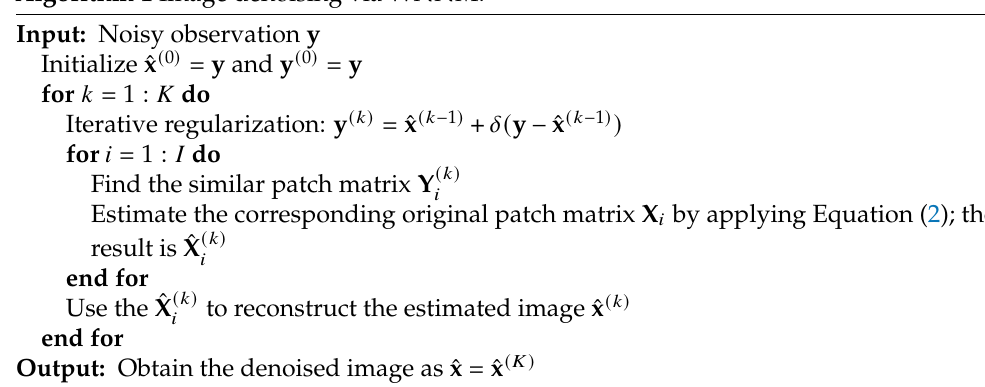
Algorithm 1 Image denoising via